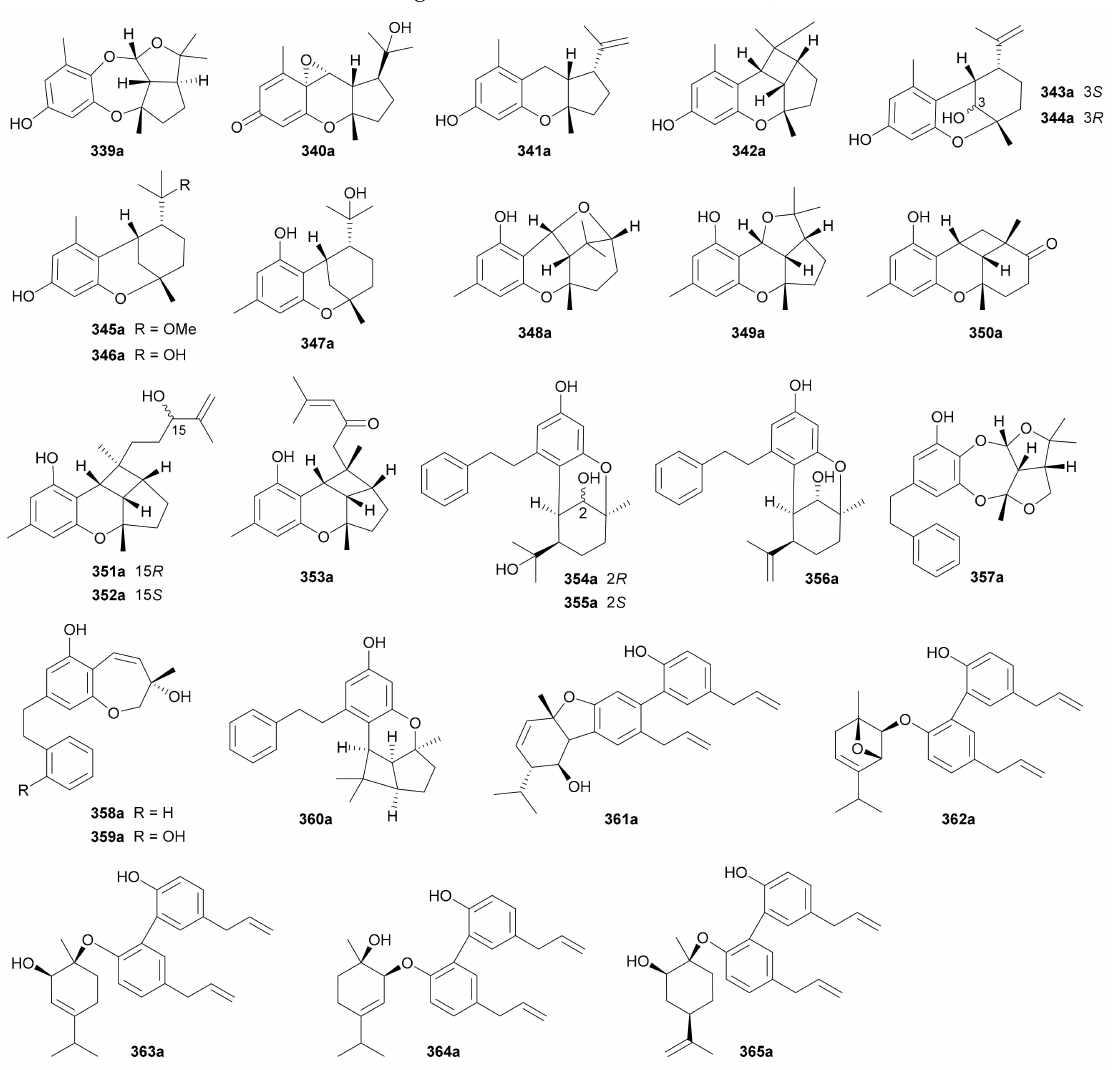
Figure 20. Structures of